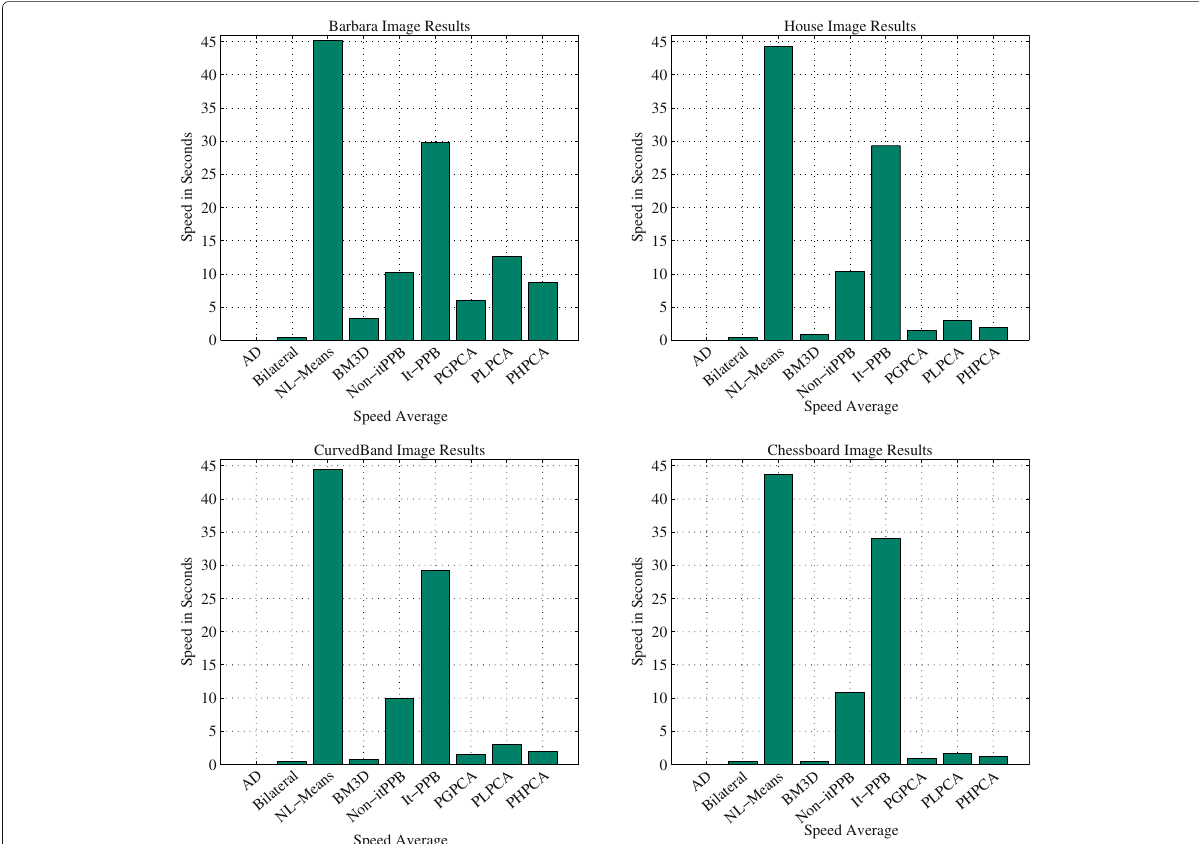
Fig. 14 The efficiency charts: four charts show the average of the consumed time in seconds for various denoising methods excluding K-SVD